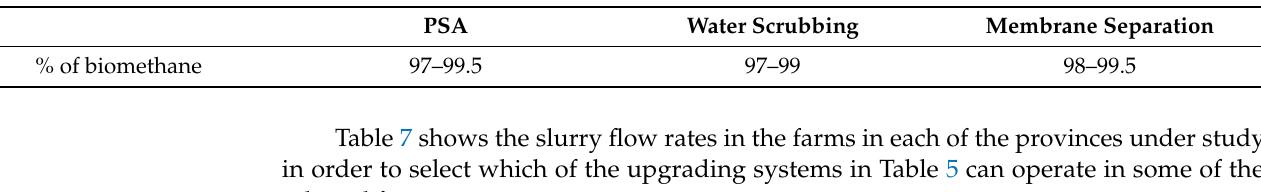
Table 6. Biomethane production ranges in each upgrading [59].